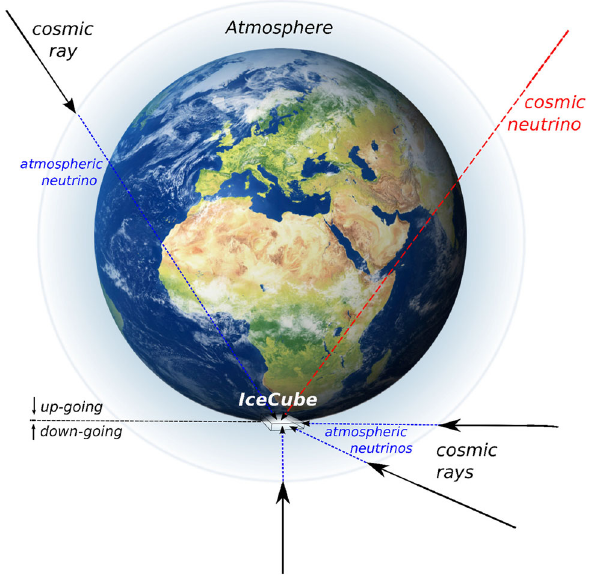
Fig. 2 A schematic illustration of the IceCube experiment